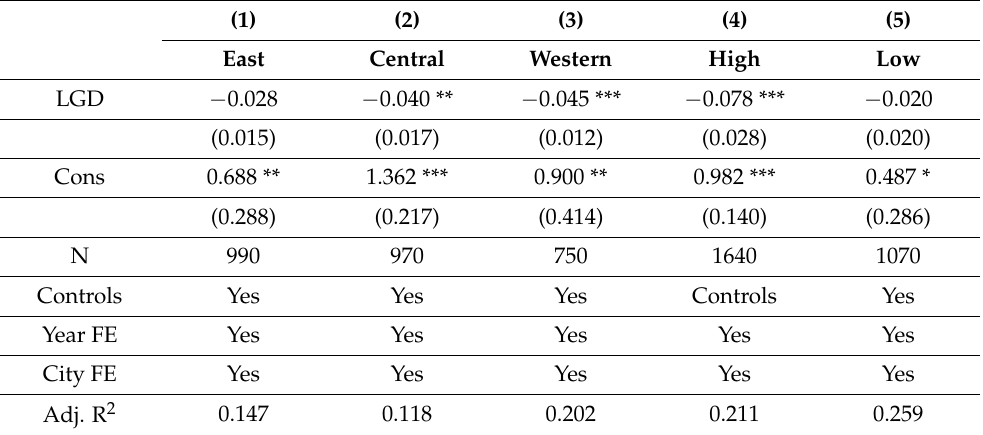
Table 7. Heterogeneity